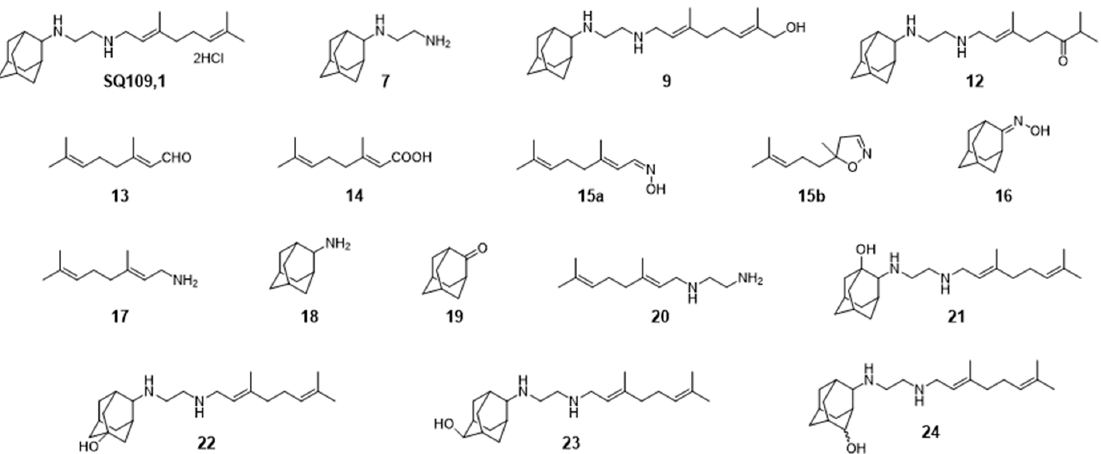
Figure 7. Structures of SQ109 and known/potential metabolites investigated. Note that, for clarity, compound numbers are those reported in previous work on M. tuberculosis [26].